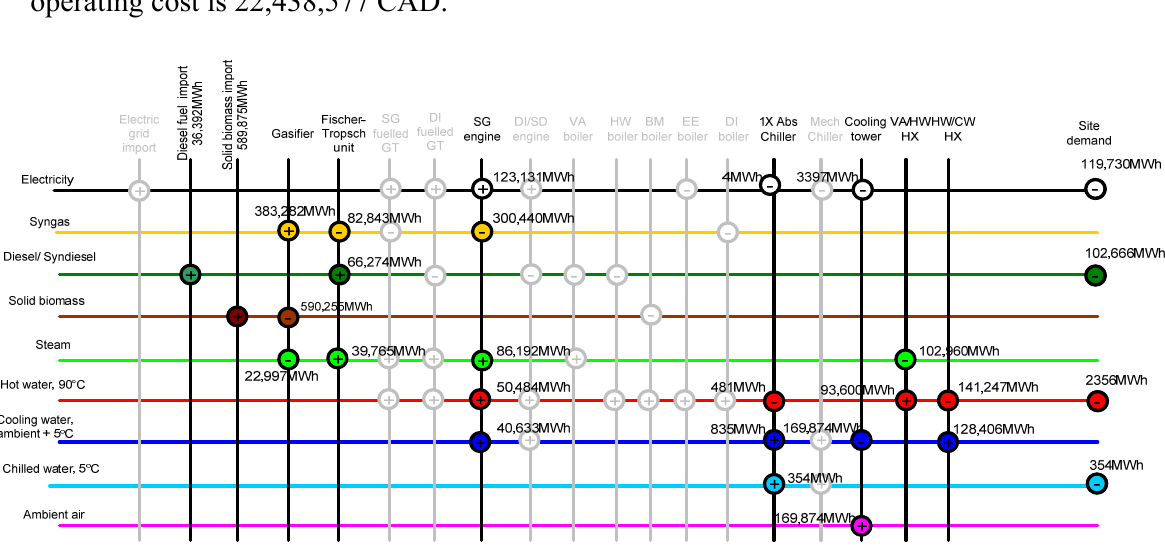
Figure 9. Off-grid optimal base case solution, showing technologies installed and main annual energy flows. The annuitized capital cost is 17,508,750 CAD, and the annualized operating cost is 22,438,577